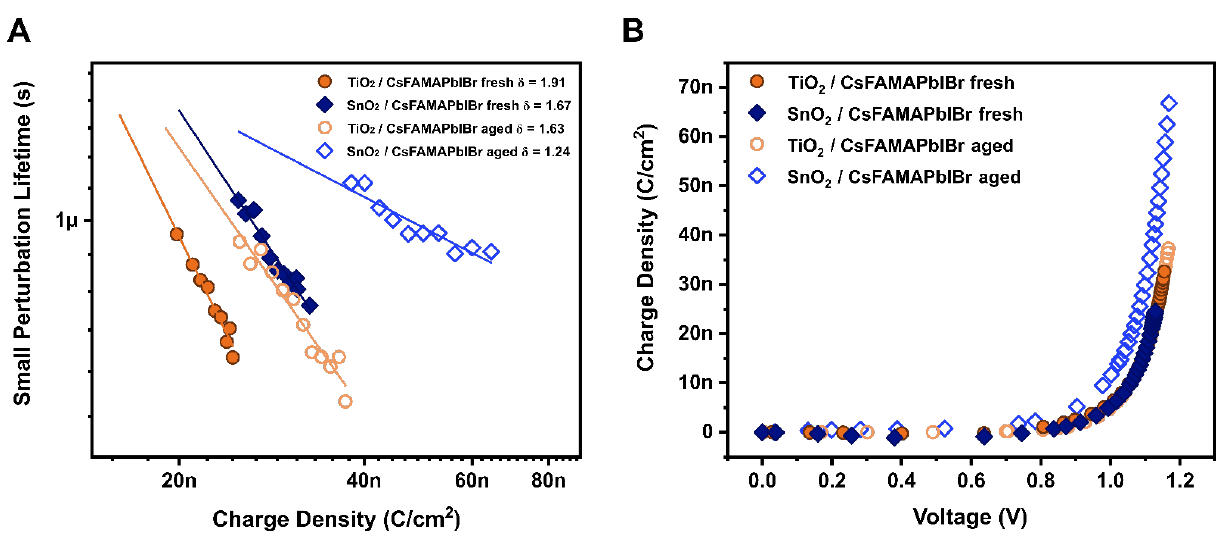
Figure 2. ( A ) Carrier lifetime obtained from TPV decays as a function of the carrier density after the subtraction of the geometric capacitance. ( B ) Carrier density obtained from the integration of the capacitance and after the subtraction of the geometric capacitance. The orange circles represent the TiO 2 /CsFAMAPbIBr, and blue diamonds represent the SnO 2 /CsFAMAPbIBr. In both cases, the filled symbols represent the fresh samples and the empty symbols — the samples after the aging treatment.